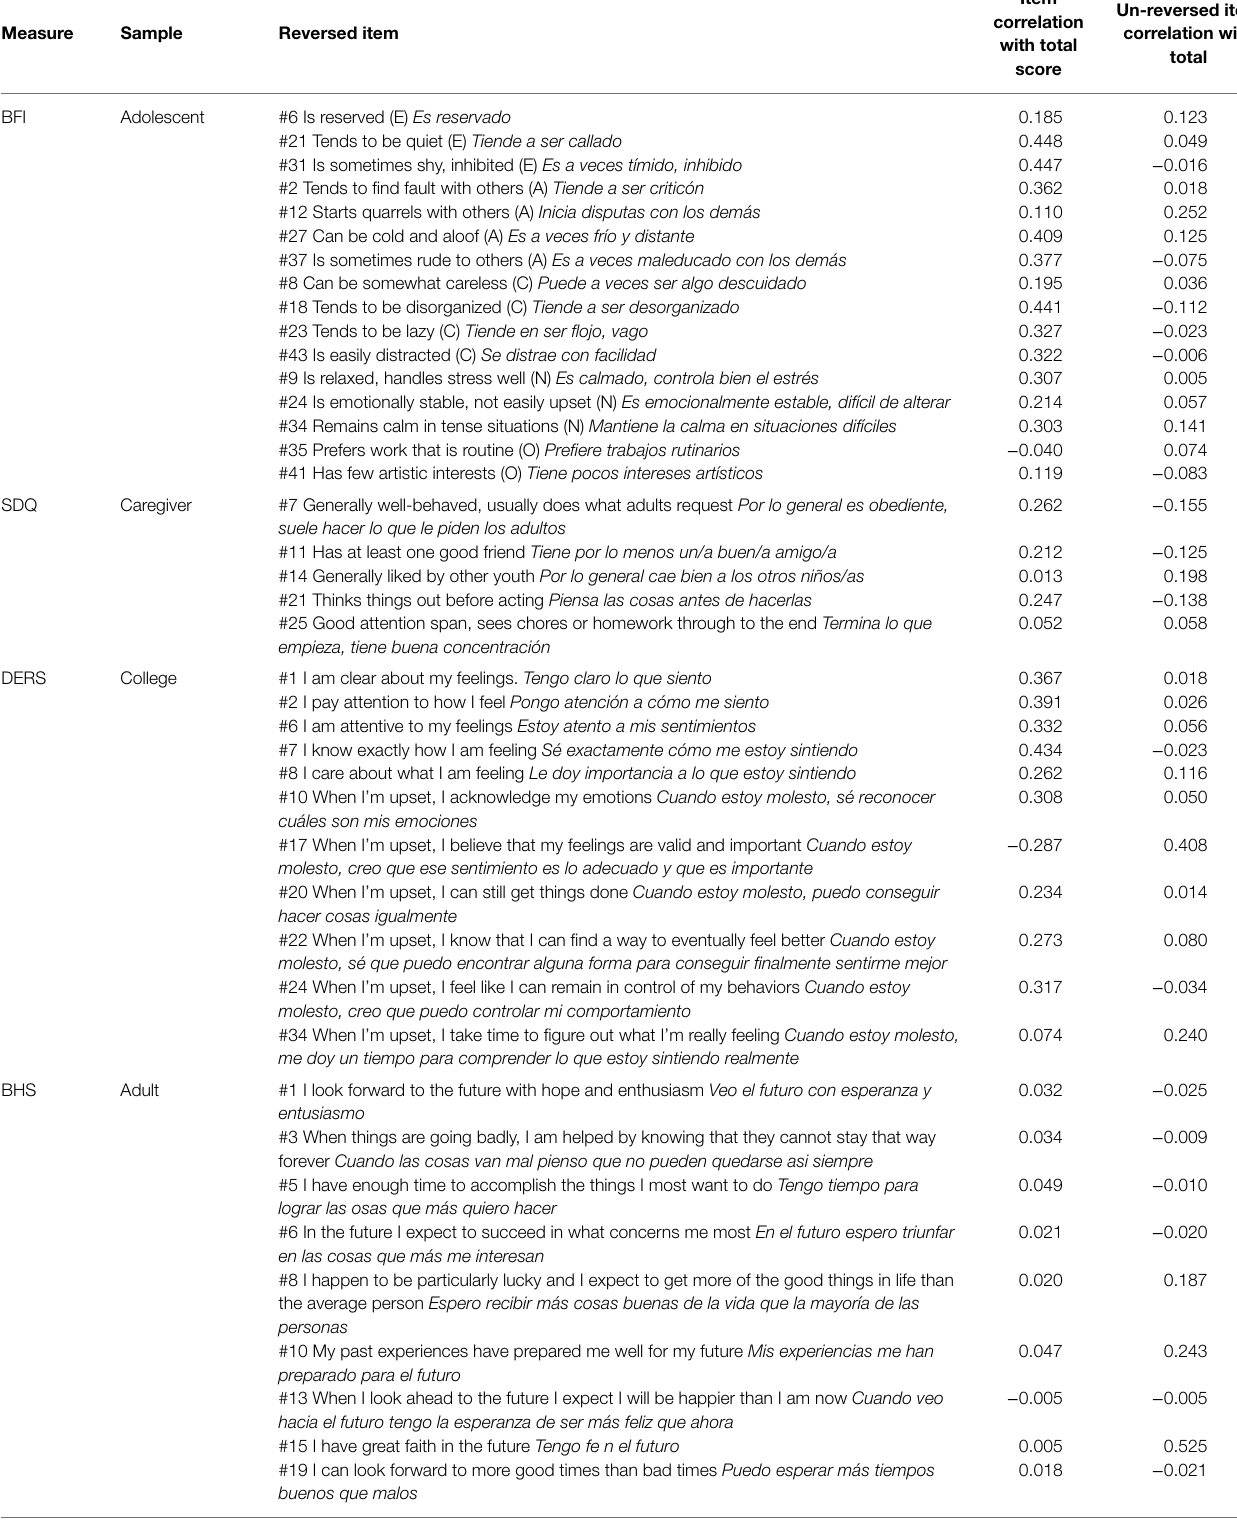
TABLE 1 | Item–total correlations across measures and samples. Measure Sample Reversed item